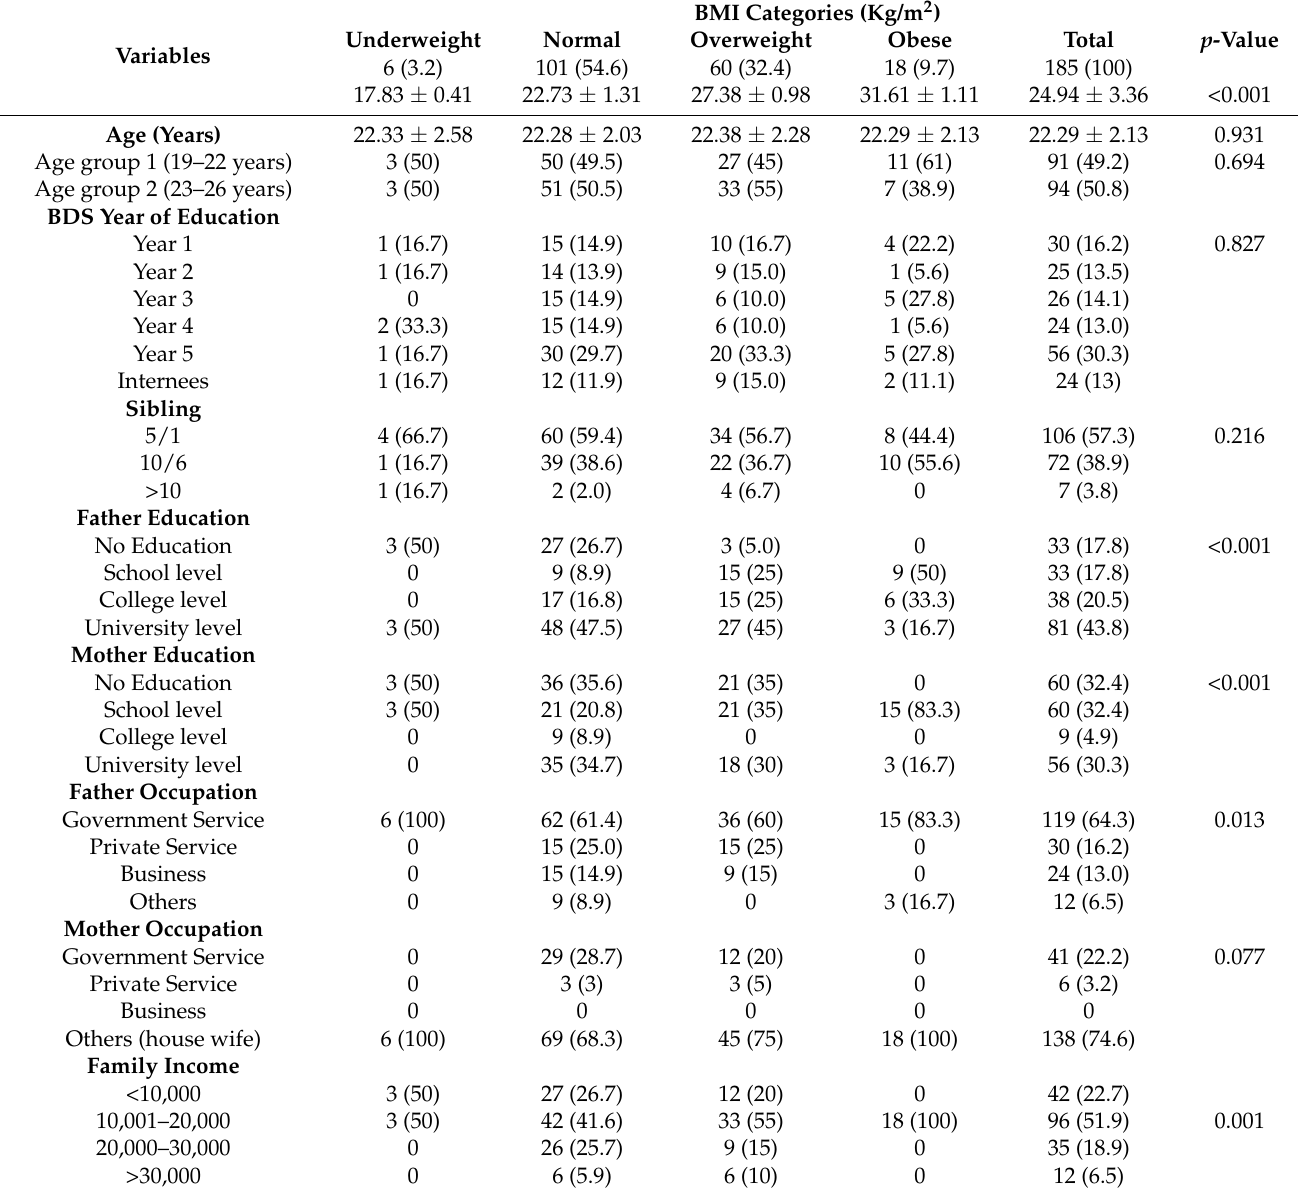
Table 1. Distribution of sociodemographic variables [ n (%)/(Mean ± SD)] among the BMI